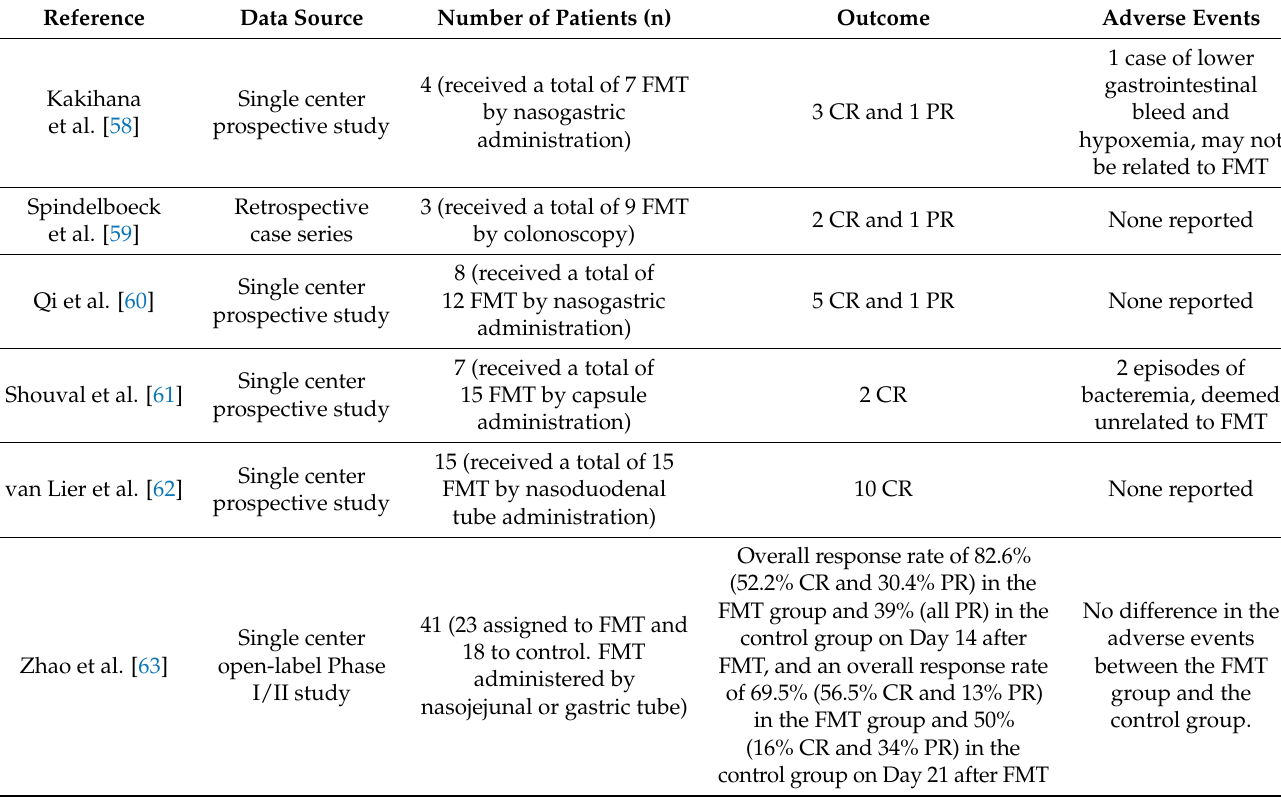
Table 2. Reported results of FMT for corticosteroid-refractory